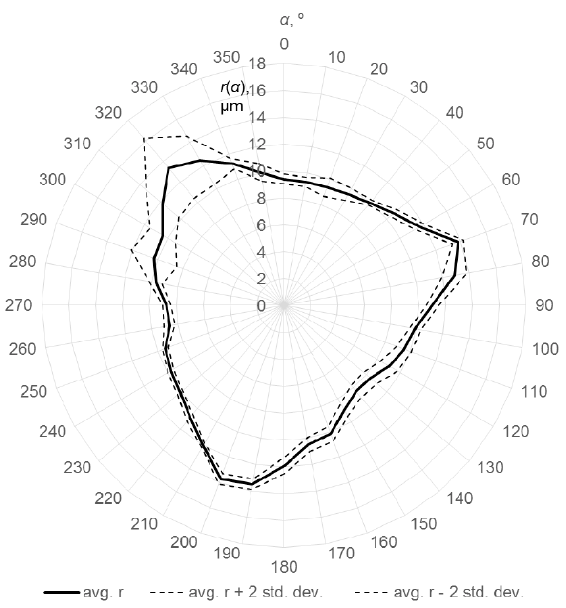
Figure 2. Results obtained in the laboratory for ultra-compact touch-trigger probe with a 50 mm stylus.